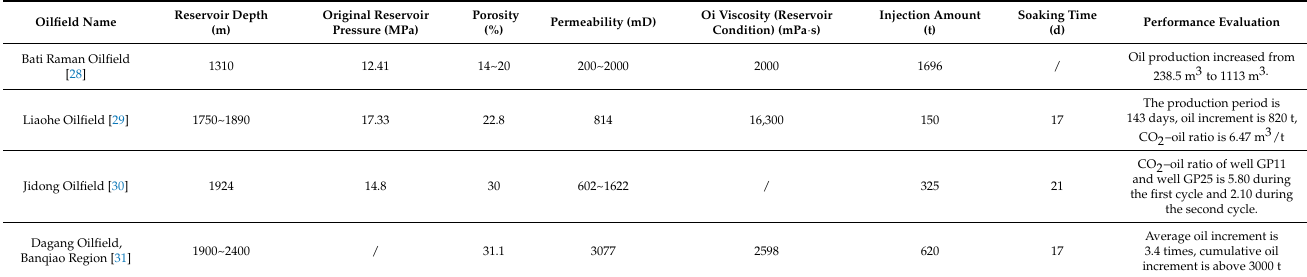
Table 1. Field pilot tests of CO 2 huff and puff for heavy-oil